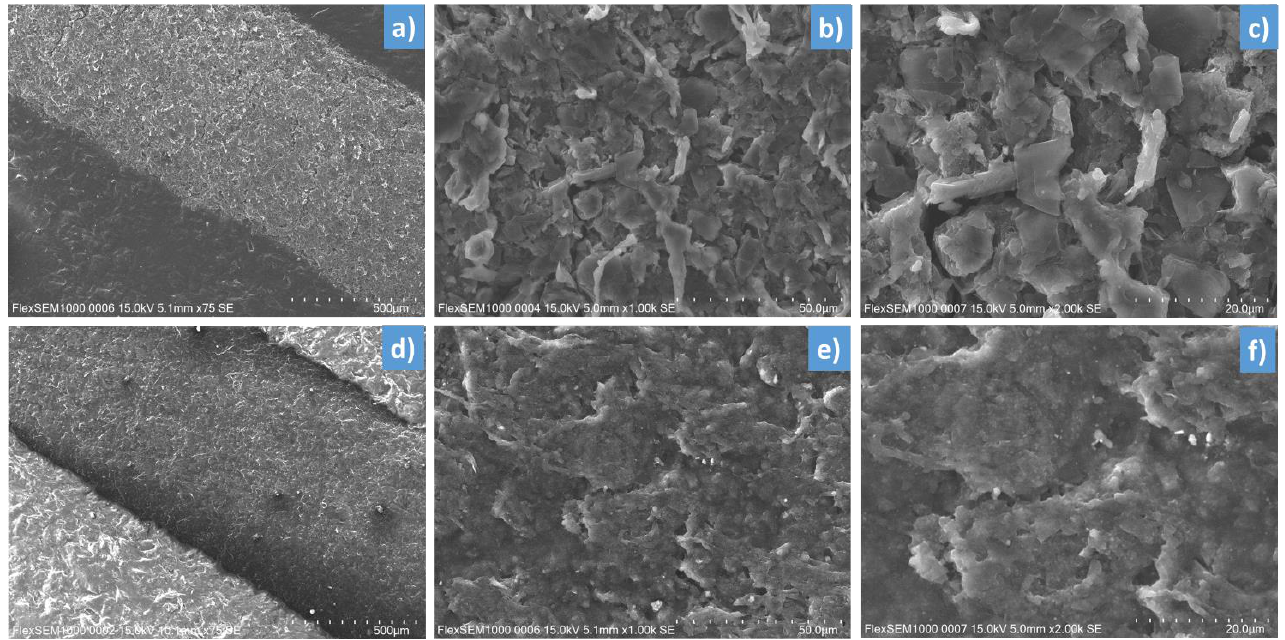
Figure 8. SEM image of 2D samples made of ( a – c ) the first ink, and ( d – f ) the second ink at magnifi- cations of ×75, ×1000, and ×2000 (from the left-hand side to the right-hand side).